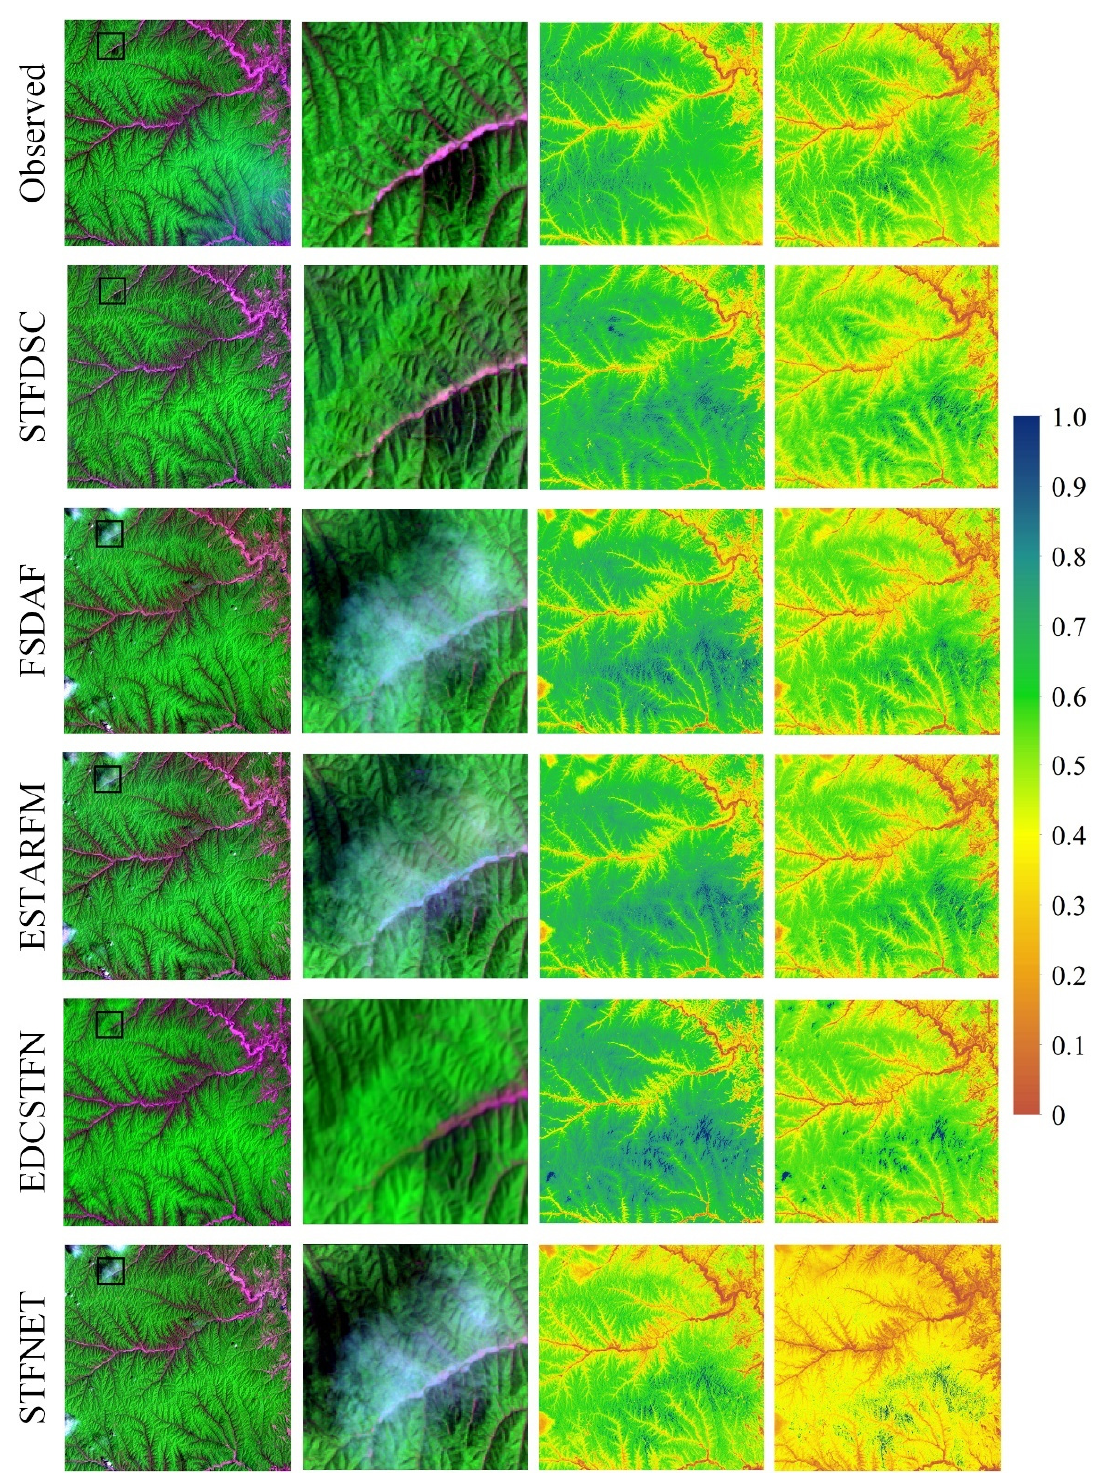
Figure 8. Fusion results on 29 April in the ZWL region. The first column shows the TM band 7-4-2 composite images of the reference image and five STF methods; the second column shows the zoomed-in details of the black rectangle in the first column; the third column shows the calculated NDVI, and the last column shows the calculated NBR.